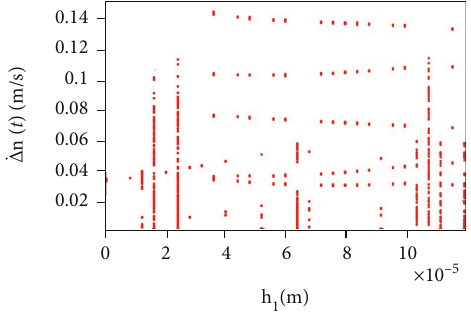
Figure 23: Bifurcation diagrams with changes in the wear when the misalignment in the x direction is 3 : 7 × 10 − 4